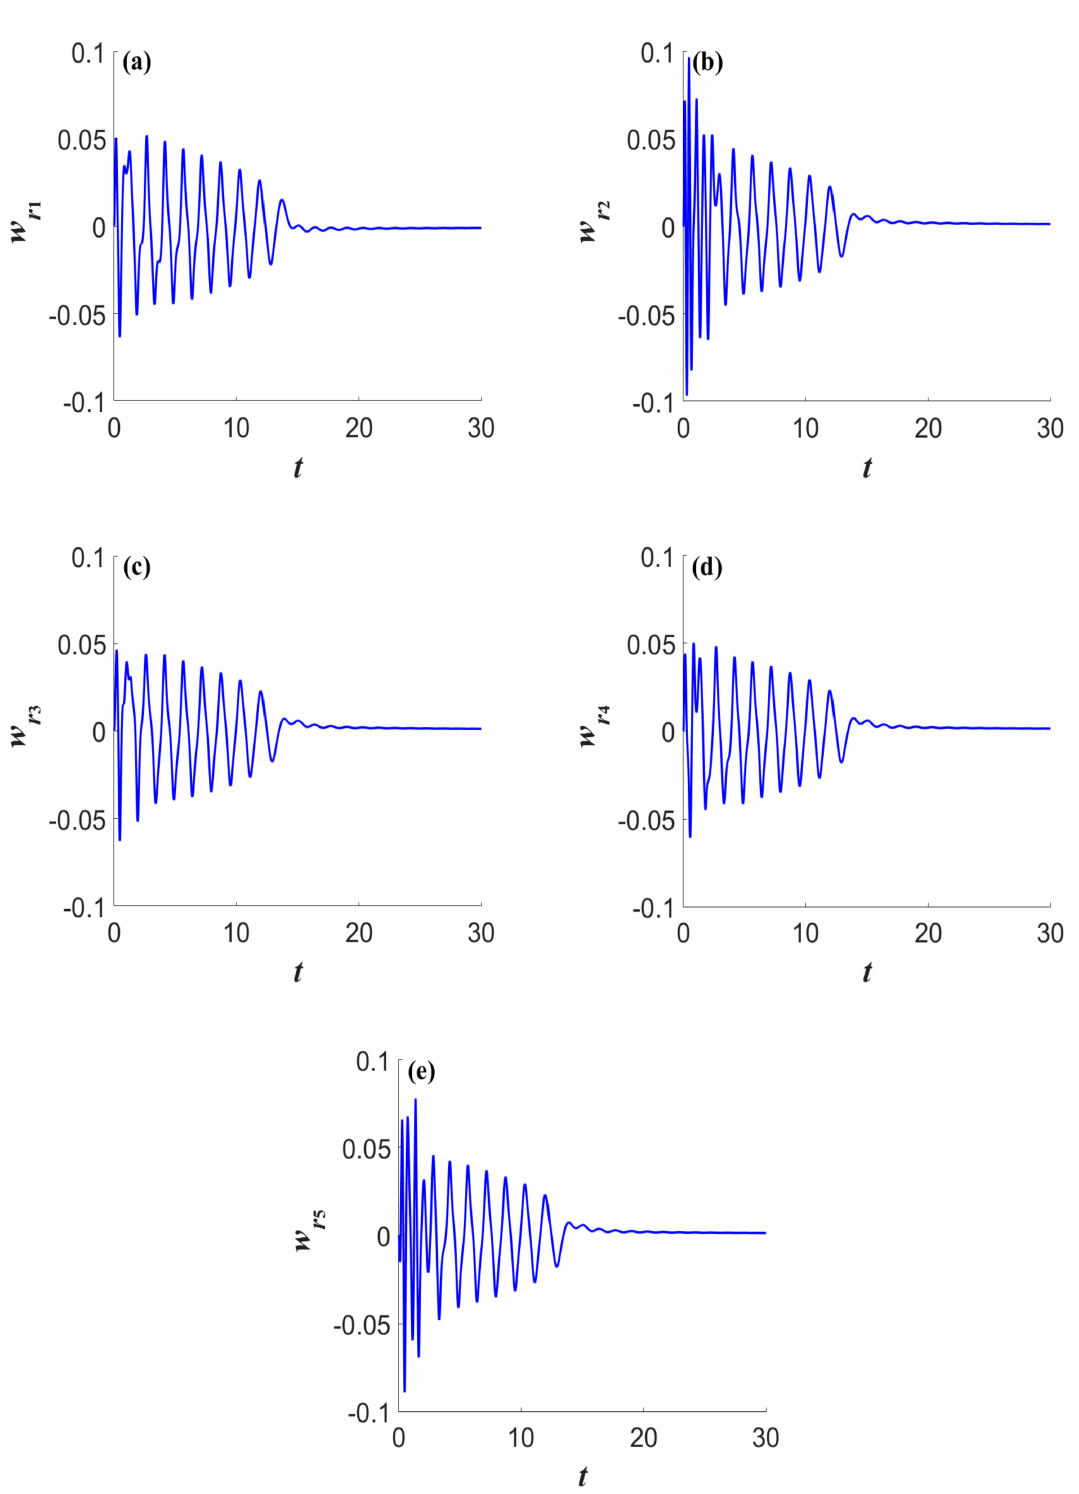
Figure 6. The relative motion between the plate and each substructure of five NESs when f = 5: ( a ) the relative motion between the plate and the N 1 ; ( b ) the relative motion between the plate and the N 2 ; ( c ) the relative motion between the plate and the N 3 ; ( d ) the relative motion between the plate and the N 4 ; and ( e ) the relative motion between the plate and the N 5